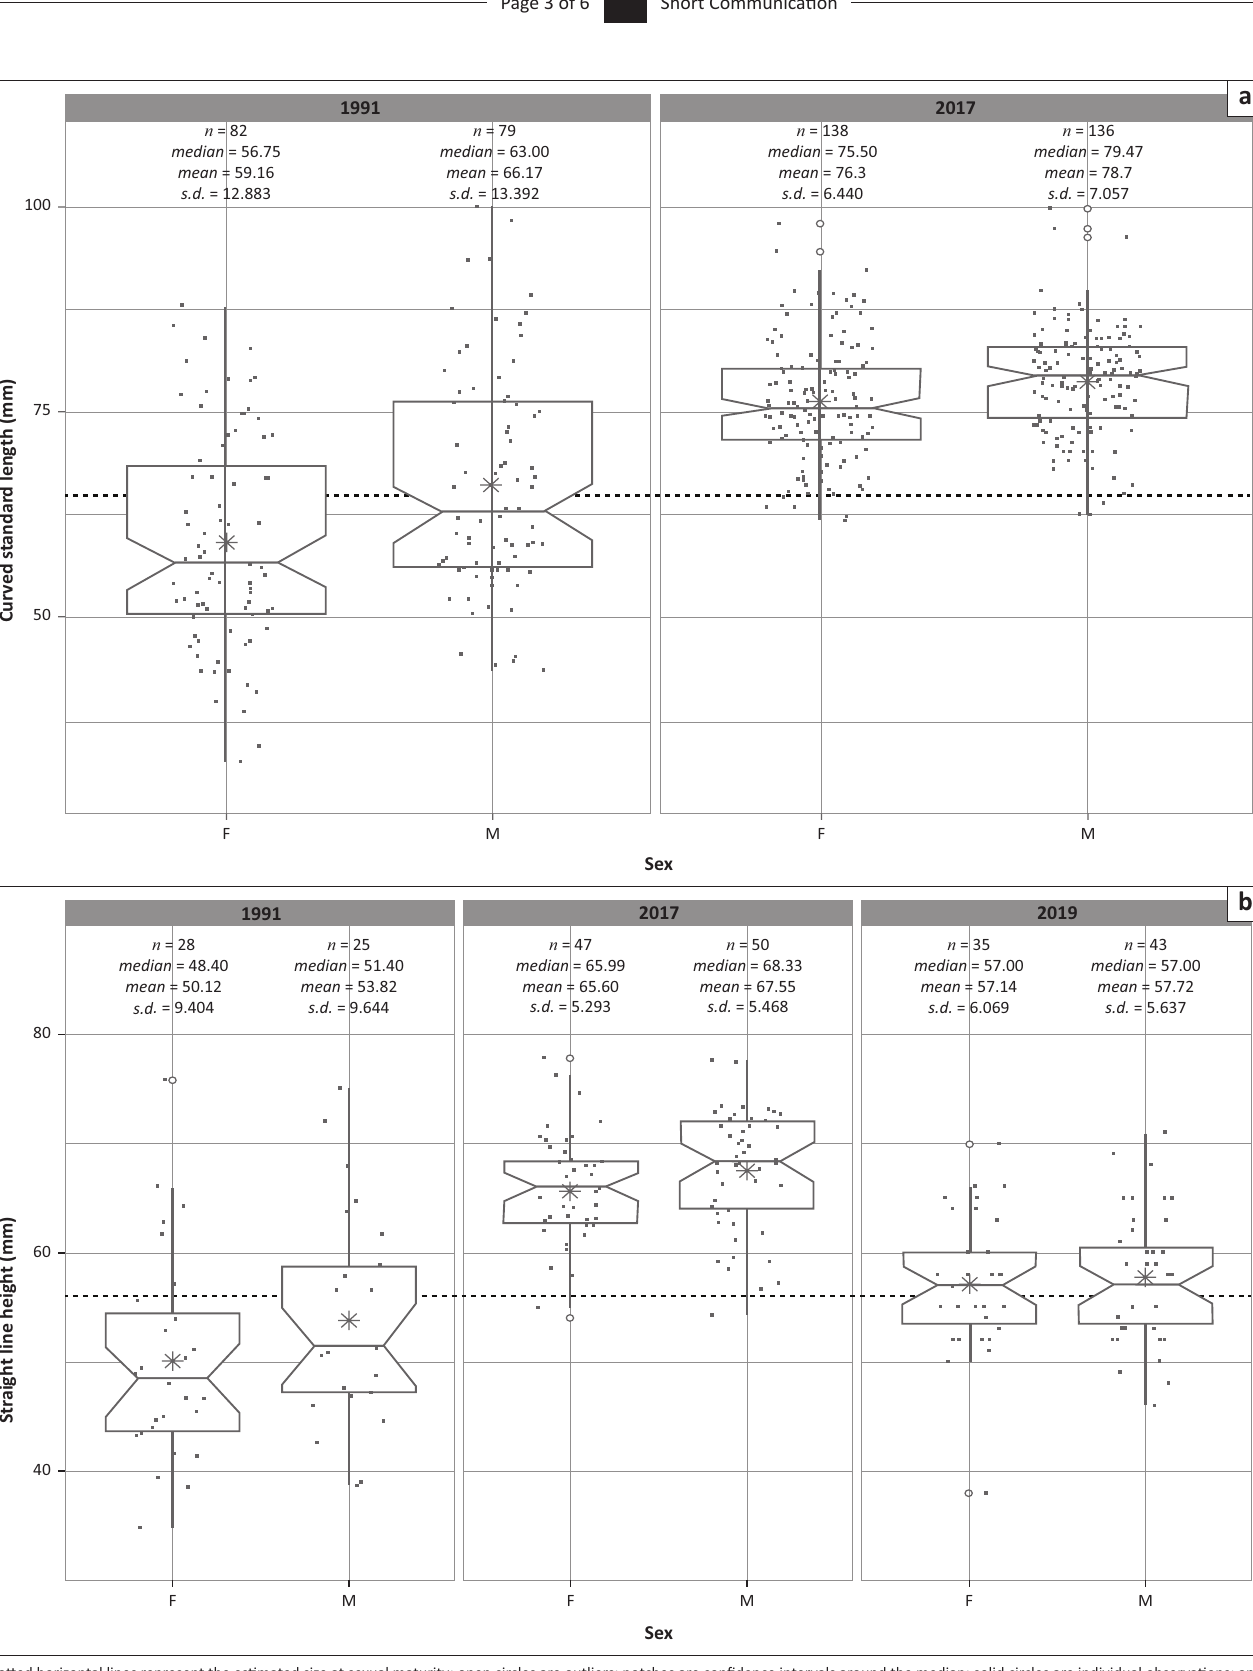
Dotted horizontal lines represent the estimated size at sexual maturity; open circles are outliers; notches are confidence intervals around the median; solid circles are individual observations; and asterisks represent mean values. The sample size ( n ), median, mean and standard deviation ( s.d. ) around the mean are provided in the text associated with each plot. F, Female; M, Male. FIGURE 1: Box and whisker plots of Hippocampus capensis separated by sex showing the minimum, first quartile, median, third quartile and maximum sizes of (a) SL for preserved (1991 and 2017) samples, and (b) Ht for preserved (1991 and 2017) and live samples straight